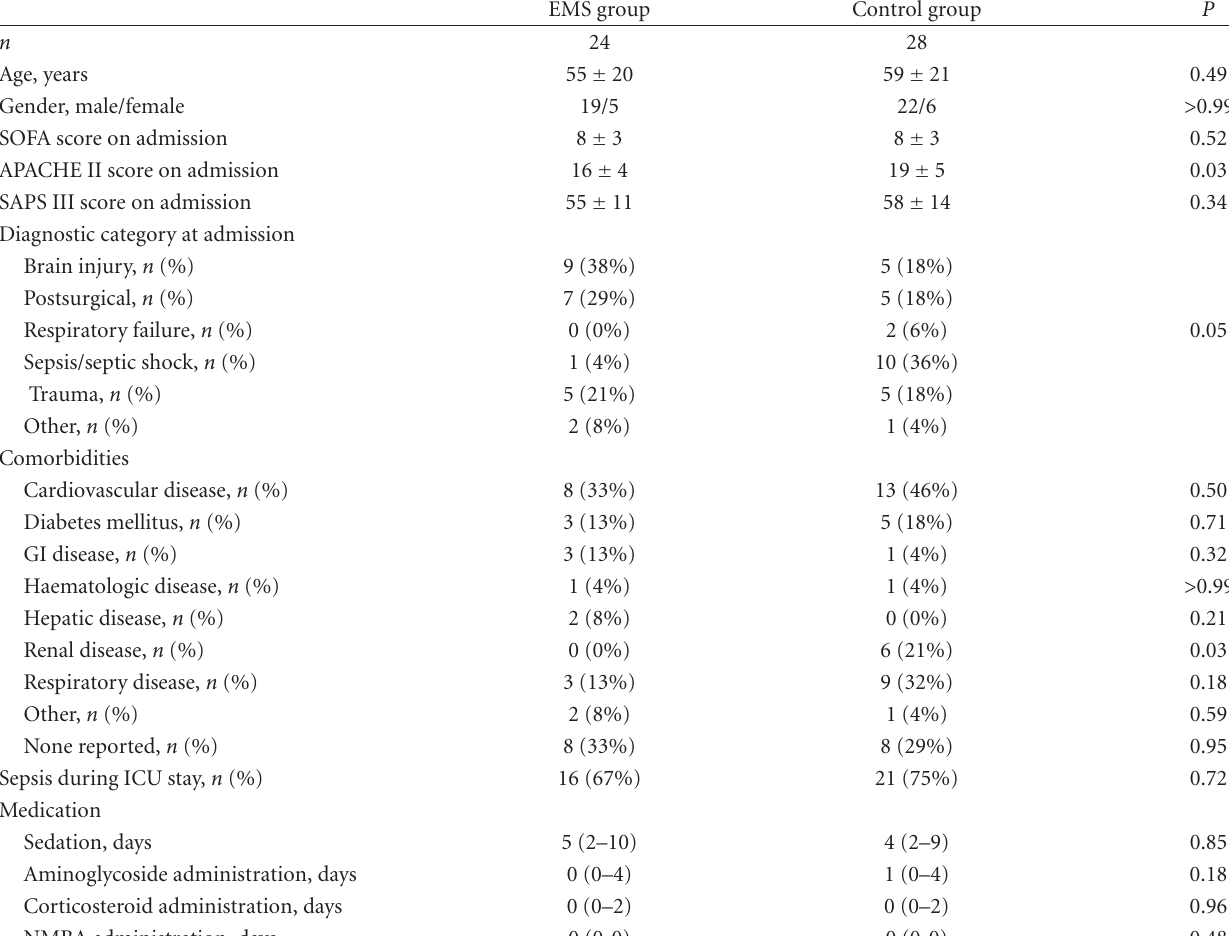
Table 1: Baseline characteristics of the patients finally evaluated in the EMS group and the control group (mean ± SD; in medication variables: median (25th–75th